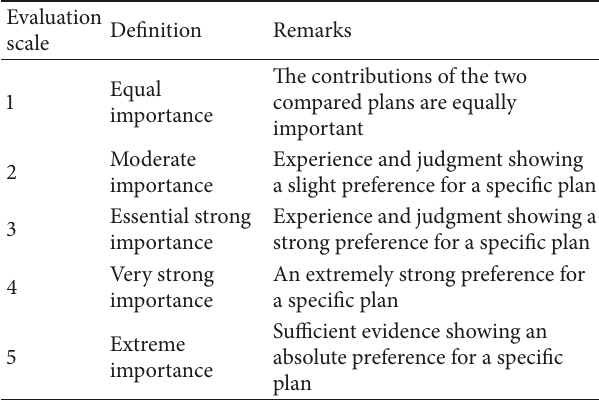
Table 2: Definition of the ANP evaluation scale anchors. Evaluation